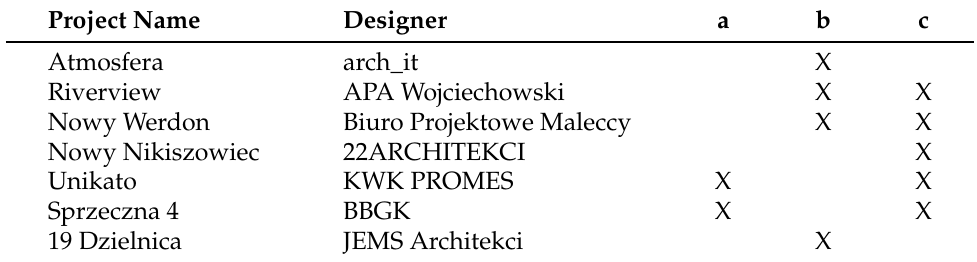
Table 1. List of irregularities in relation to the analysed housing